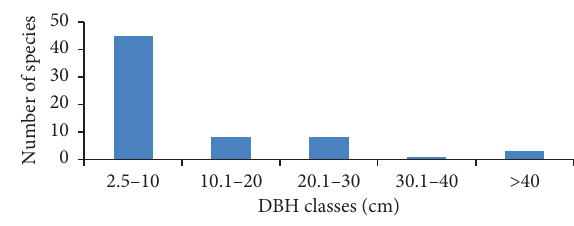
Figure 8: DBH class with number of species.